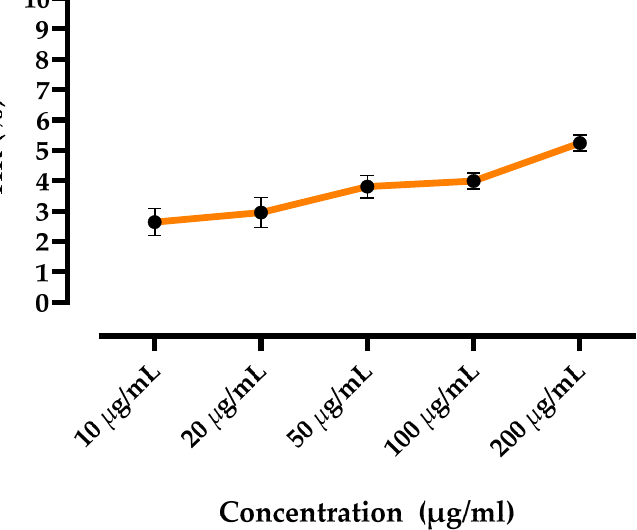
Figure 3. Evolution of the hemolysis level. The results are expressed as mean ± standard deviation. The assays were performed in triplicate. HR = Hemolysis ratio.